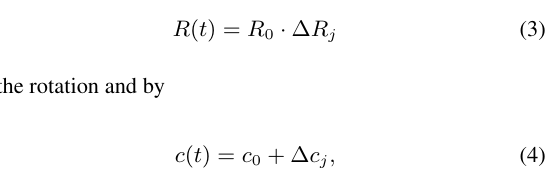
Table 1: Specifications of the evaluated cameras and their estimated readout time. The field of view denotes the horizontal/vertical field of view as we measure it. The FC300X has a 20mm lens and the Canon S110 has a zoom lens set to 24mm (both in 35mm format equivalent). The readout time estimations coming from our model have been confirmed by DJI for the FC200 and FC300X cameras. it into n equally spaced sectors, each of them corresponding to one set of c j , R j . The motion of the camera during readout can then be modeled by